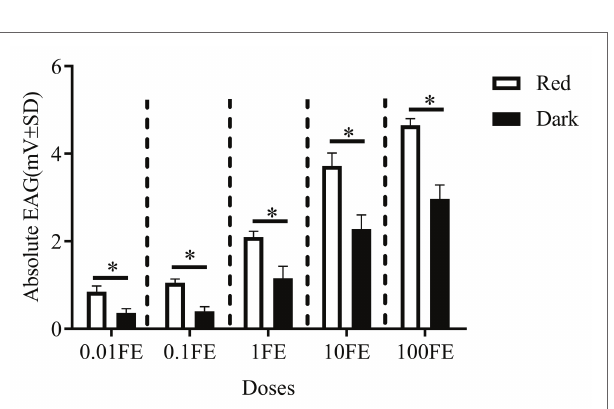
FIGURE 6 | Electroantennographic (EAG) responses to the mixture of sex pheromones of male C. punctiferalis reared under red light and dark conditions during scotophase. Data are shown as mean ± SD, from four replicates. Asterisks above columns mean significant differences ( * p < 0.05, ns: no significant difference), by independent sample t -tests. FE: female equivalent.